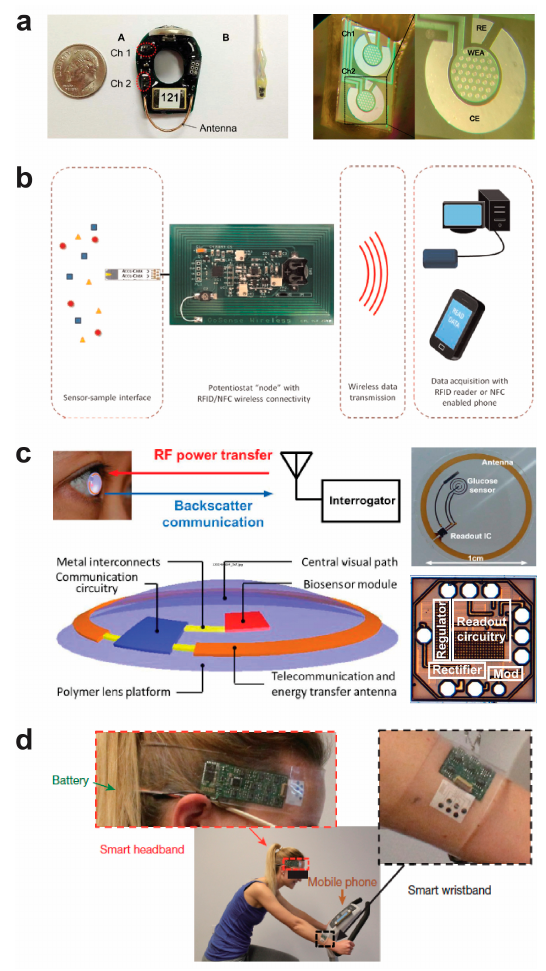
Figure 5. Wireless “potentiostat” system-based bioelectronic sensors. ( a ) Pinnacle 8151 wireless potentiostat with two independent electrochemical cells. Reprinted with permission from [74].